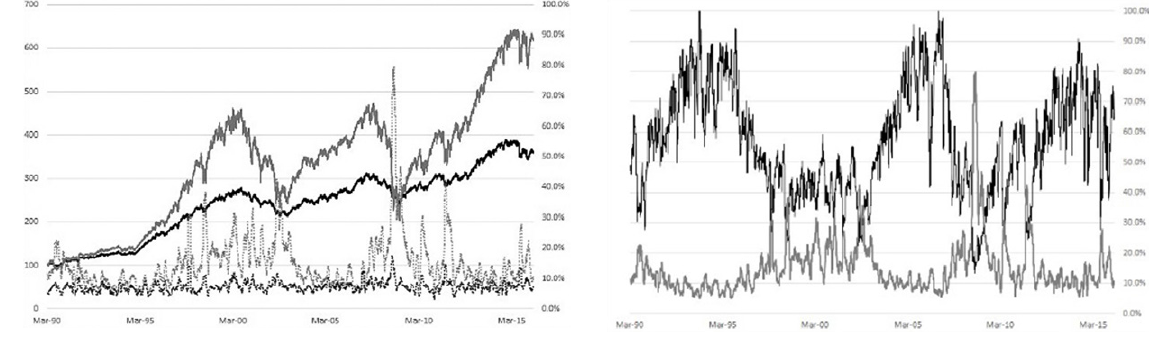
Figure 2. Comparative results for the TVS VIX portfolio and the S&P 500 Note: The left side presents the path of TVS VIX (solid black line) and of S&P 500 (solid gray line), and the TVS VIX rolling standard deviation (dotted black line) and the S&P rolling standard deviation (dotted gray line). The right side presents how the equity exposure of the TVS VIX (solid black line) changes with respect to the volatility of the S&P 500 (solid gray line).